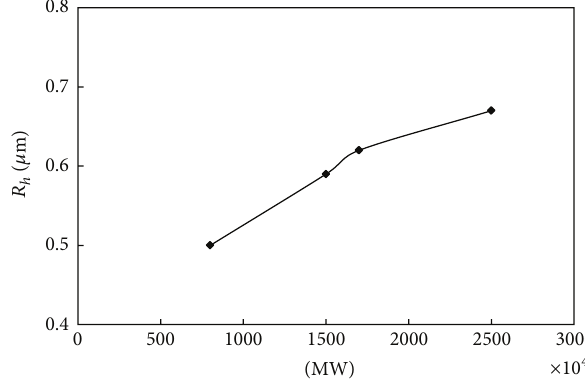
Figure 2: Relation between the hydrodynamic feature size and the polymer molecular weight.